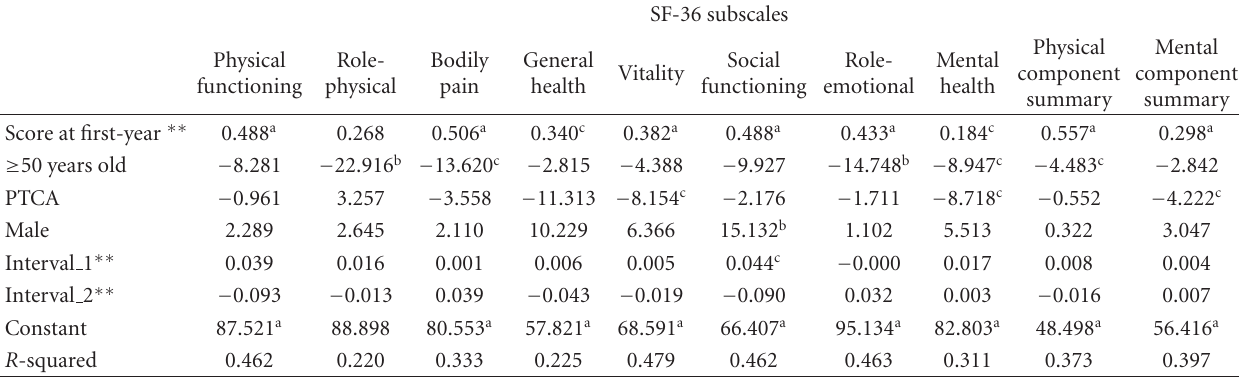
Table 6: Results of multiple regression analyses ∗